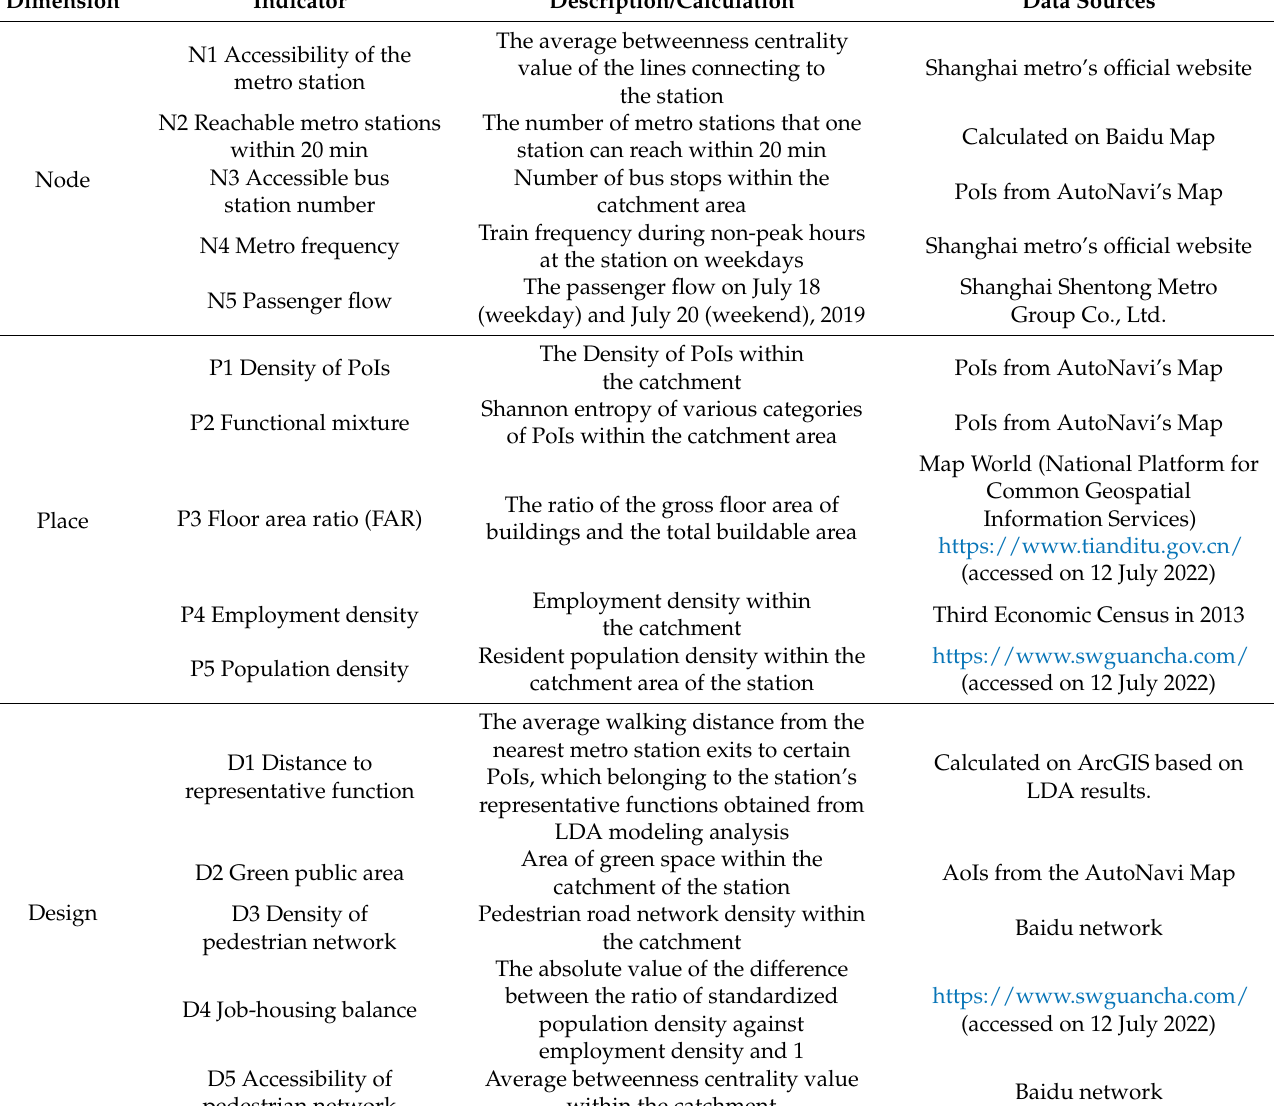
Table 2. Overview of TOD